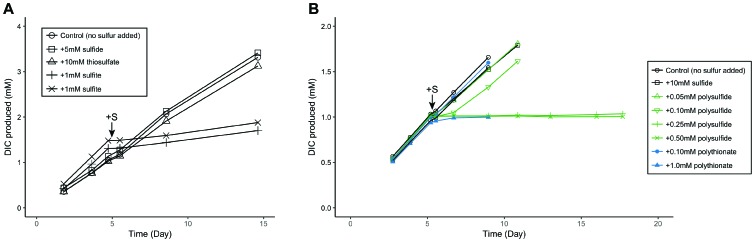
Metabolic response of ANME to (A) sulfite and (B) zero-valent sulfur additions, as measured by 13C-labeled dissolved inorganic carbon (DIC) production from 13CH4. Zero-valent sulfur was added in the form of polysulfide and polythionate. Arrows indicate time of sulfur compound additions. Sulfite (1 mM) and zero-valent sulfur (>0.25 mM polysulfide or 1.0 mM polythionate) additions showed an inhibitory effect on methane oxidation in contrast to control or other sulfur compounds. Methane seep sediment ID 7142, dominated by ANME-2a and ANME-2c lineages, was used in these experiments.